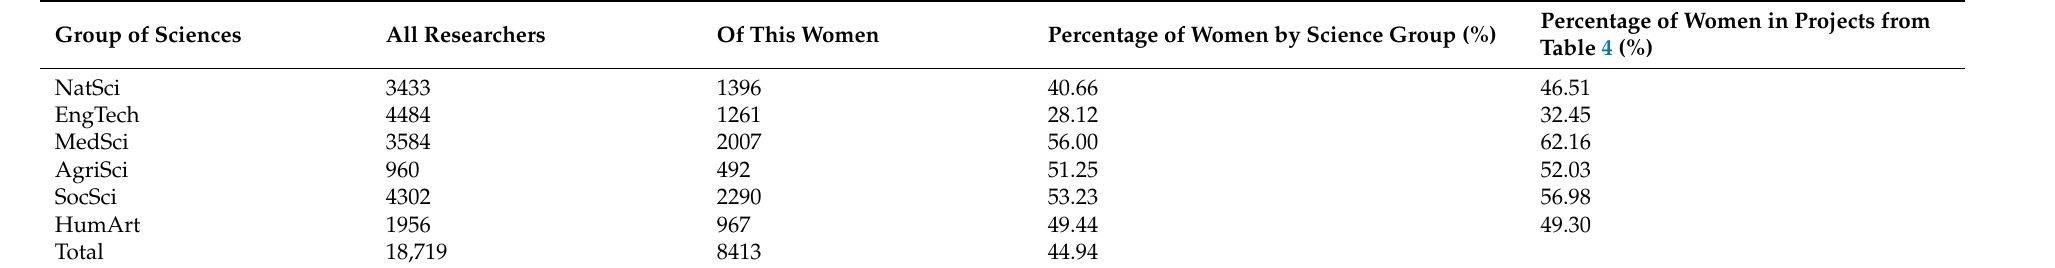
Table 7. Structure of R&D capacities by S&T discipline groups 2020, percentage of women